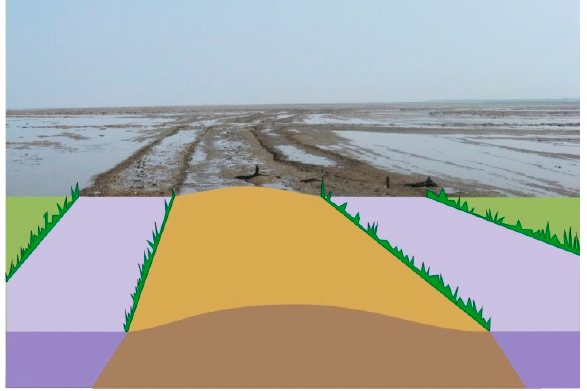
Figure 13. Reconstruction of a historical lane with ditches on either side. Photograph and sketch: J.